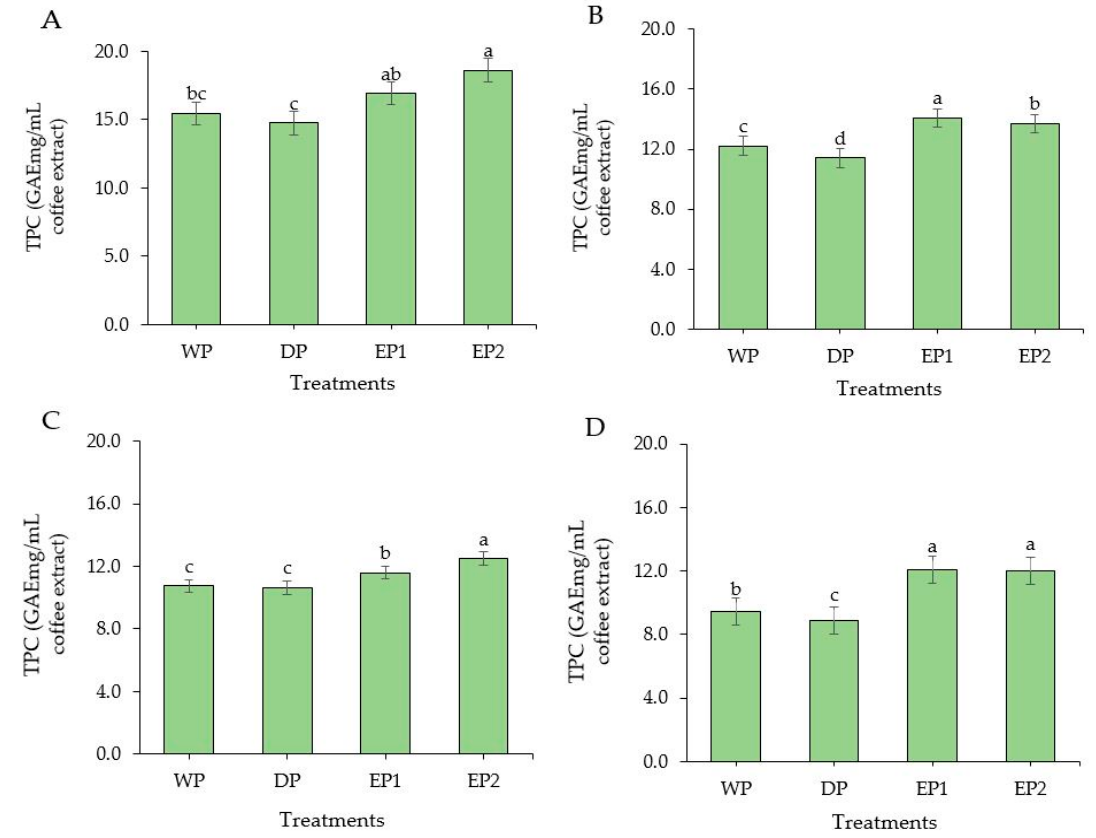
Figure 4. Total phenolic content of green and roasted coffee beans that obtained using different processing methods. (( A ): Green beans; ( B ): Light roasted, ( C ): Medium roasted; ( D ): Dark roasted). EP1: elephant dung coffee (pulp was completely digested); EP2: elephant dung coffee (pulp was not digested); WP: wet-processed beans; DP: dry-processed beans. Different letters above the bars indicate statistically significant difference at p < 0.05.